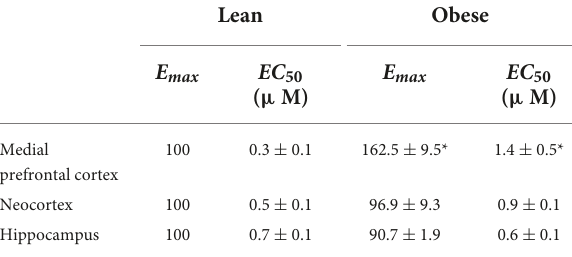
TABLE 2 Computer assisted curve fitting of WIN 55,212-2-stimulated [ 35 S]GTP γ S to brain membranes of Zucker rats. Lean Obese E max EC 50 E max EC 50 ( µ M) ( µ M) Medial 100 0.3 ± 0.1 162.5 ± 9.5* 1.4 ± 0.5* prefrontal cortex Neocortex 100 0.5 ± 0.1 96.9 ± 9.3 0.9 ± 0.1 Hippocampus 100 0.7 ± 0.1 90.7 ± 1.9 0.6 ± 0.1 E max values are expressed as percent over lean. Data are means ± SEM ( n = 3). Significance of difference from the corresponding values in lean counterparts (* P <